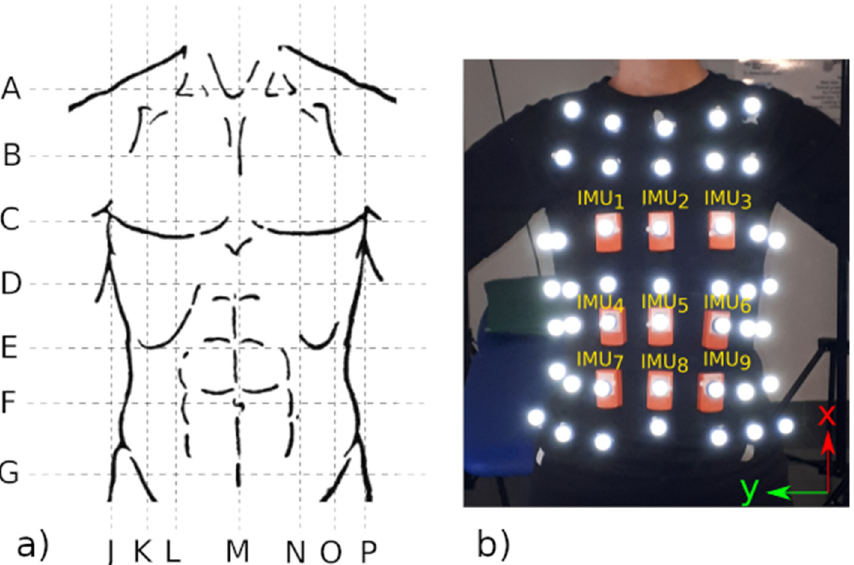
Figure 1. The left panel ( a ) shows the grid adopted to uniformly span the anterior trunk wall with reflective markers. Horizontal lines are craniocaudally identified as follows: A connects the lateral ends of both clavicles, B is equally distant from A and C, C connects the nipples, D crosses the xiphoid process, E connects the lower costal margins, F crosses the umbilicus, and G connects the anterior iliac spines. Vertical lines are identified as follows: K and O cross the right and left anterior iliac spines, respectively; M is the midline crossing the umbilicus; L and N cross the nipples; and J and Pare right and left midaxillary lines, respectively. The right panel ( b ) shows the adopted marker set. Note that markers arelocated on the nodes of the grid shown in the left panel except for those related to line A,whichare positioned along the clavicles. The panel also shows the location of the nine IMUs (orange boxes) and their orientation (see x- and y-axes in the bottom right corner). During the experimental sessions, participants were asked to breathe normally fora 2 min time window. At the beginning of each trial, IMU 1 (Figure 1) was delicately beat